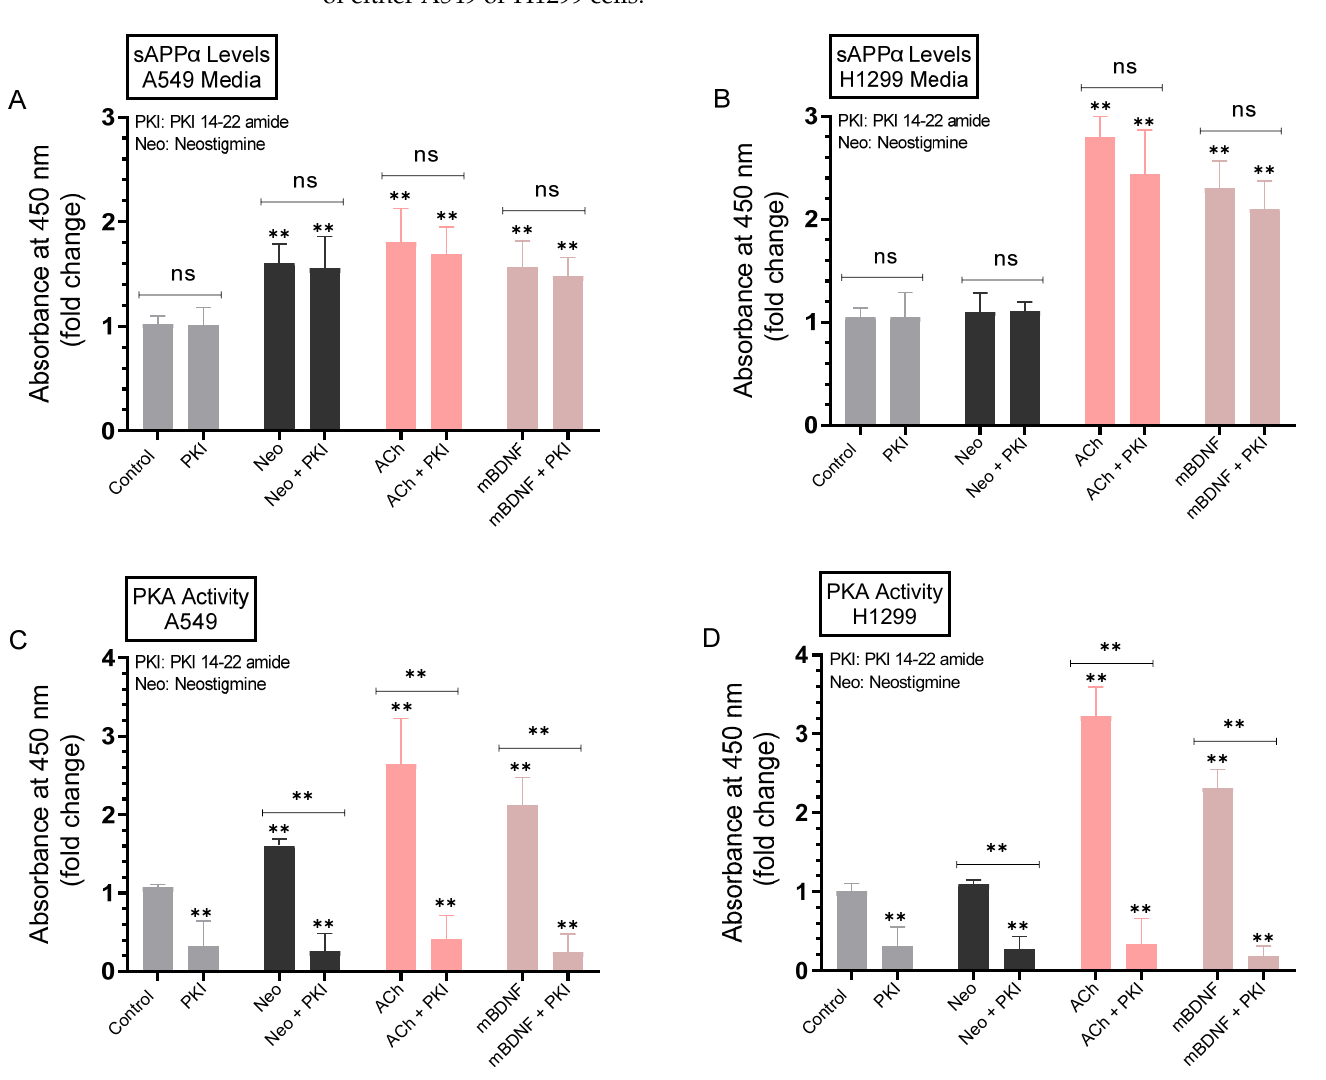
Figure 6. Blocking PKA activity had a minimal effect on the level of sAPP α in A549 and H1299 cell media. Cells (0.2 × 10 5 ) were grown in 10% FBS-supplemented media for 24 h. The following day, the cell monolayers were incubated in serum-free media for 24 h, then treated for 72 h with the PKA inhibitor (PKI 14-22 amide, 5 µ M), neostigmine (Neo, 50 µ M), ACh (100 nM), mBDNF (5 nM), or in combination. Levels of sAPP α released into the culture media of A549 (A) and H1299 (B) cells during the 3-day incubation period were measured as described in the Methods section on the same amount of protein (3 μ L of 600 μ g/mL total protein) of each sample. PKA activity was measured in A549 (C) and H1299 (D) cells as described in the Methods section. Data from five independent assays, each carried out in triplicate, were averaged, normalized, and expressed as fold change relative to untreated cells (control) using the GraphPad 9.4.1 software. The graphs summarize the results expressed as means ± SD (n = 5). Asterisks (*) indicate a statistically significant difference from the corresponding control of each cell line while absence of asterisks indicates no significance (ns). Mann-Whitney test, **p<0.0l.